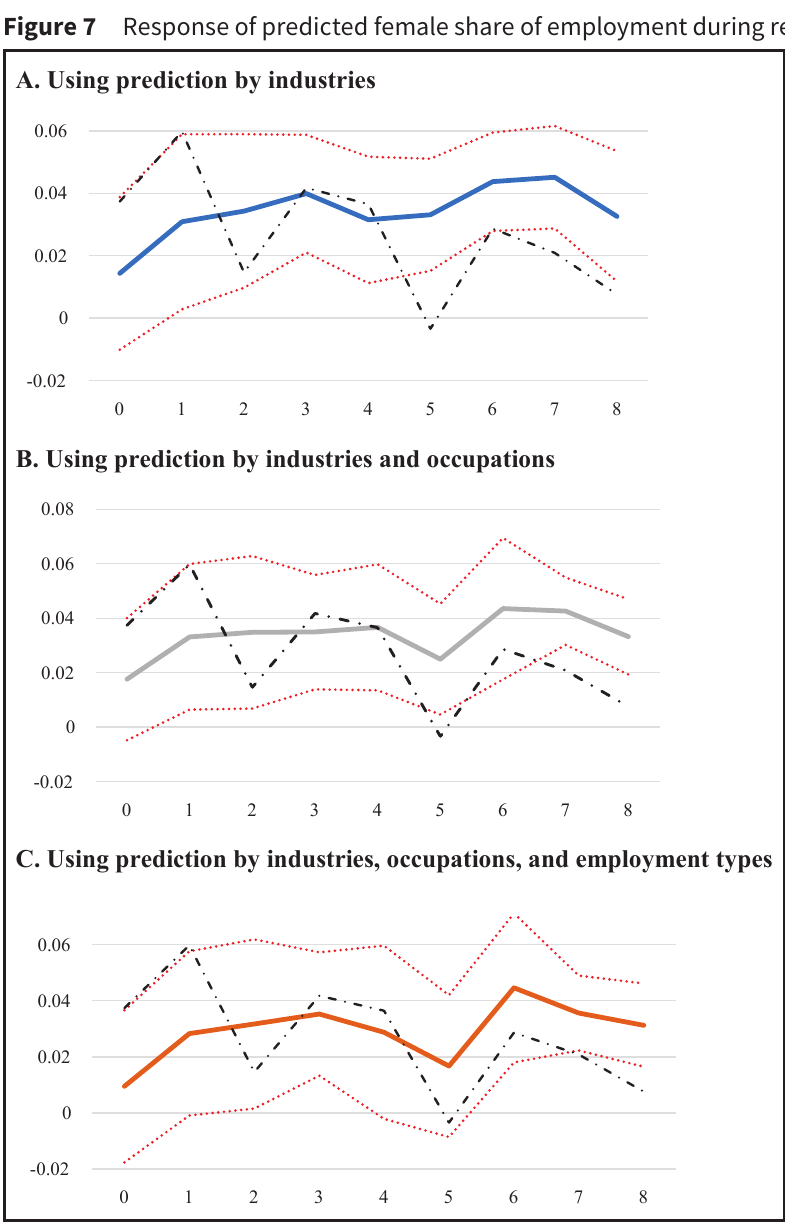
between solid and dashed lines reflect dynamics in the gender composition of employment unrelated to industries, occupations, and/or employment types.